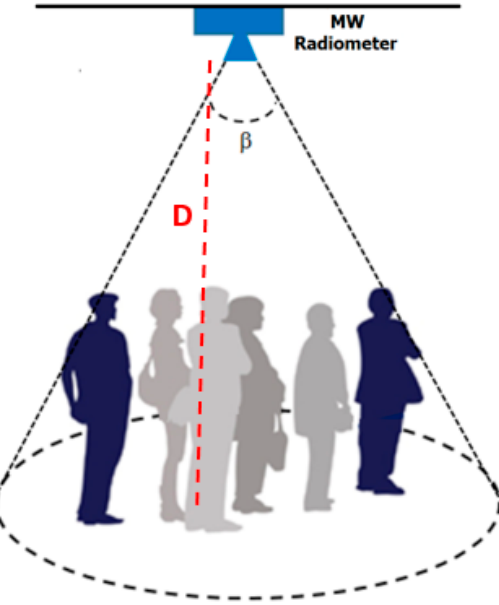
Figure 14. Scene sensed by a microwave radiometer mounted on the ceiling; β is the antenna half-power beamwidth. D is the distance antenna-floor.